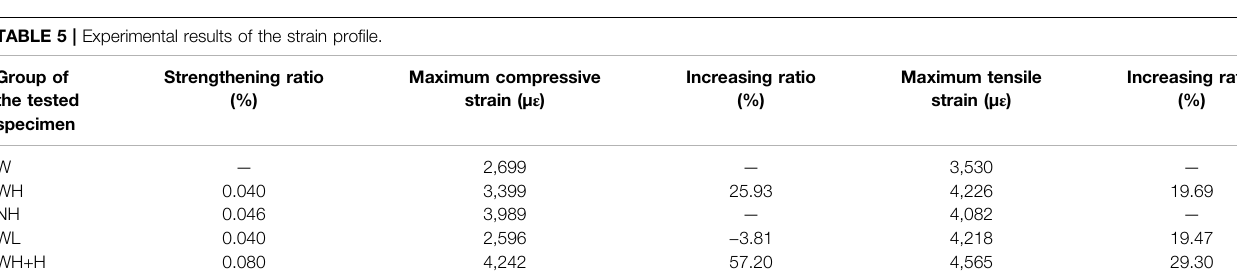
TABLE 5 | Experimental results of the strain pro fi le. Group of the